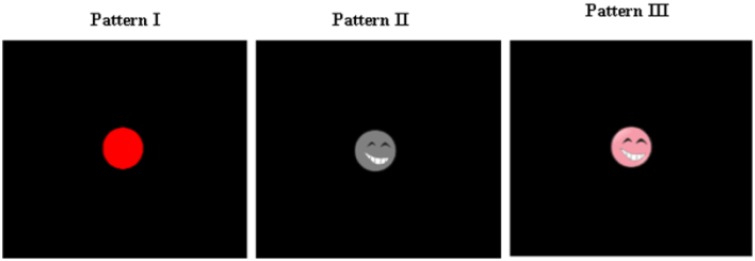
The stimulus display. The stimulus is shown in a layout that is independent of eye gaze.